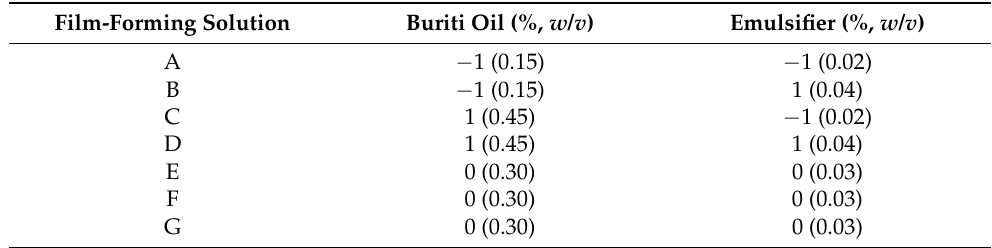
Table 1. Independent variables (buriti oil and emulsifier concentrations) codified and uncodified used for the preparation of cassava-starch-based